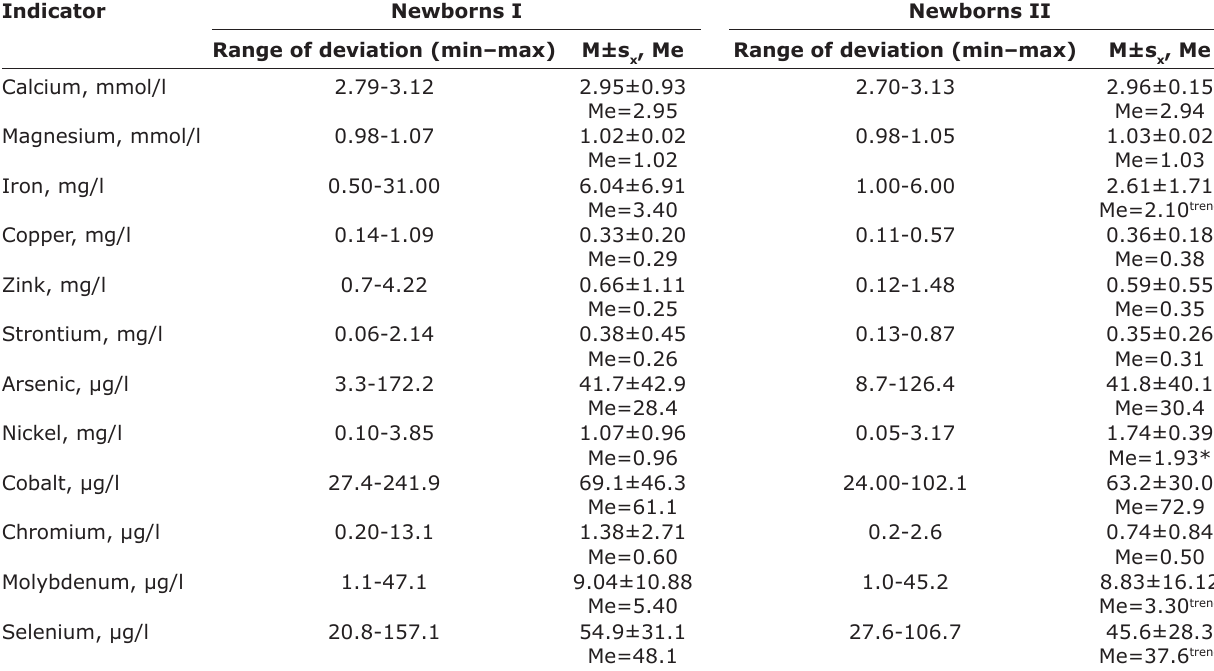
Table-3: Macroelements and microelements content in blood serum of the newborn calves. Indicator